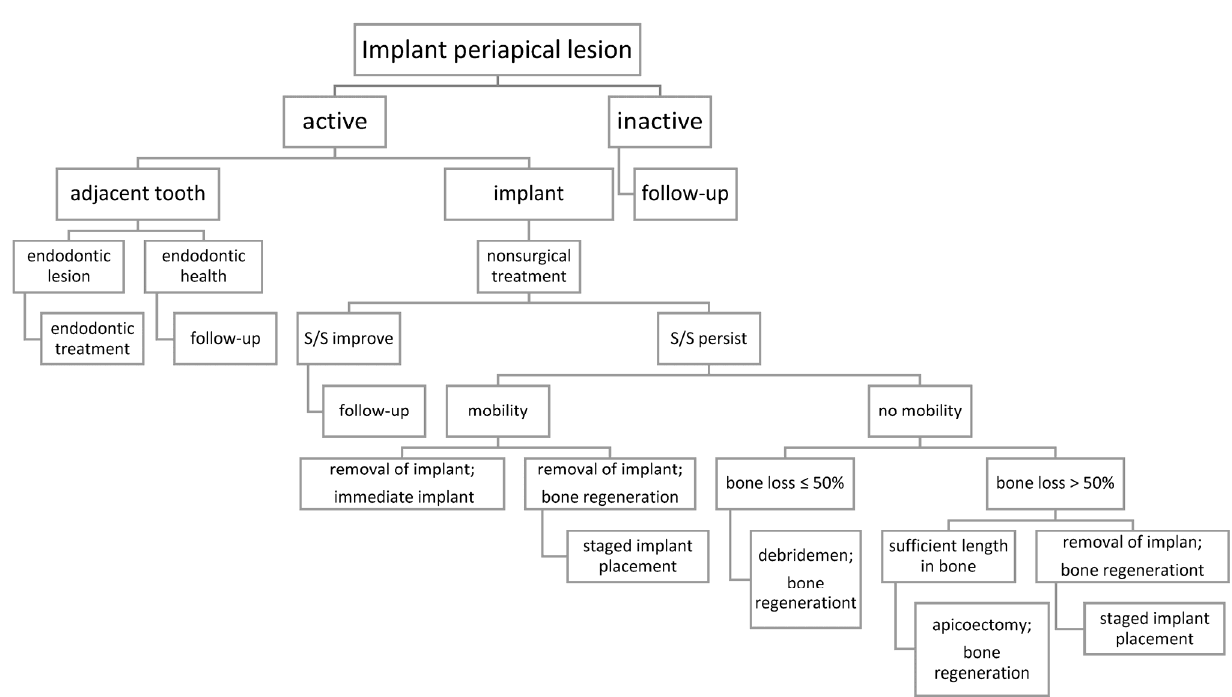
Figure 4. Treatment flowchart of implant periapical lesion. GBR, guided bone regeneration; S/S, symptoms and signs.